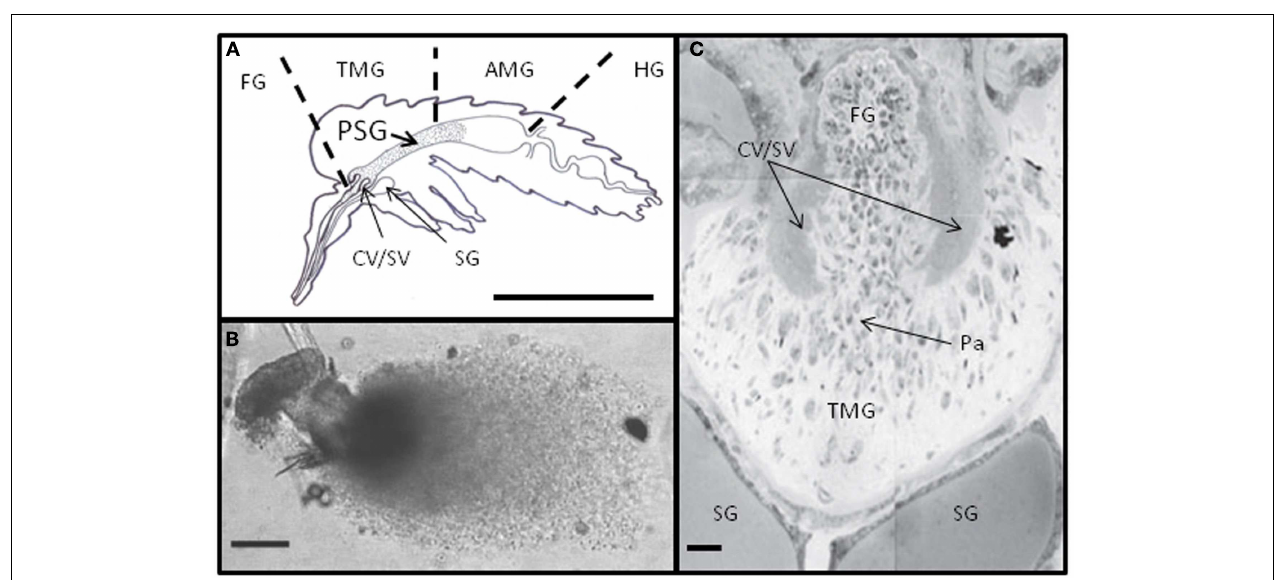
mexicana -infected Lu. longipalpis (scale bar: 100 µ m). (C) Sagittal section through the anterior thoracic midgut of a heavy L. mexicana - Lu. longipalpis infection, showing numerous attached and unattached parasites (Pa) and occlusion to the stomodeal valve (Scale bar: 10 µ